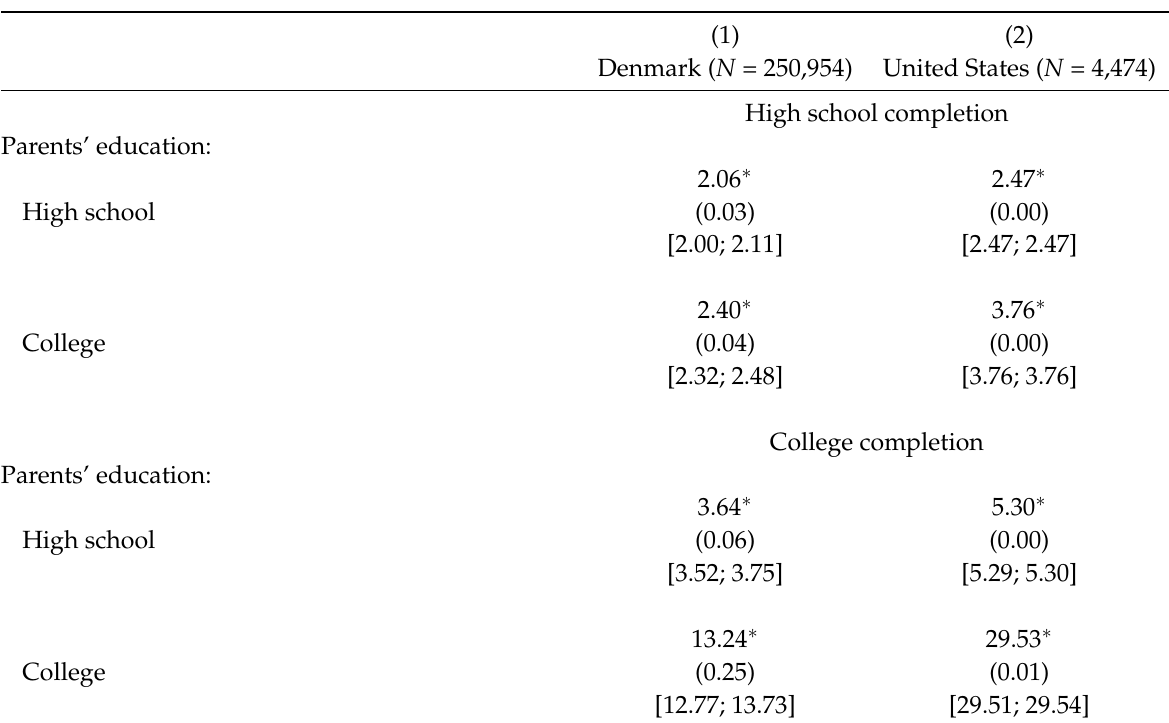
Table 5: Educational mobility by categorical measures. Children’s highest degree (2013) by parents’ highest degree, coded from degrees attained. Odds ratios (reference: no high school), with separate multinomial logit models for each